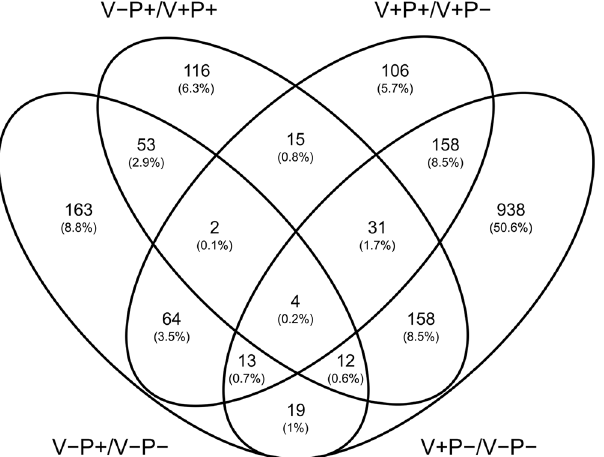
Figure 4. Numbers of unique and common genes found in the four DEG lists (Diagram generated using Venny 2.1